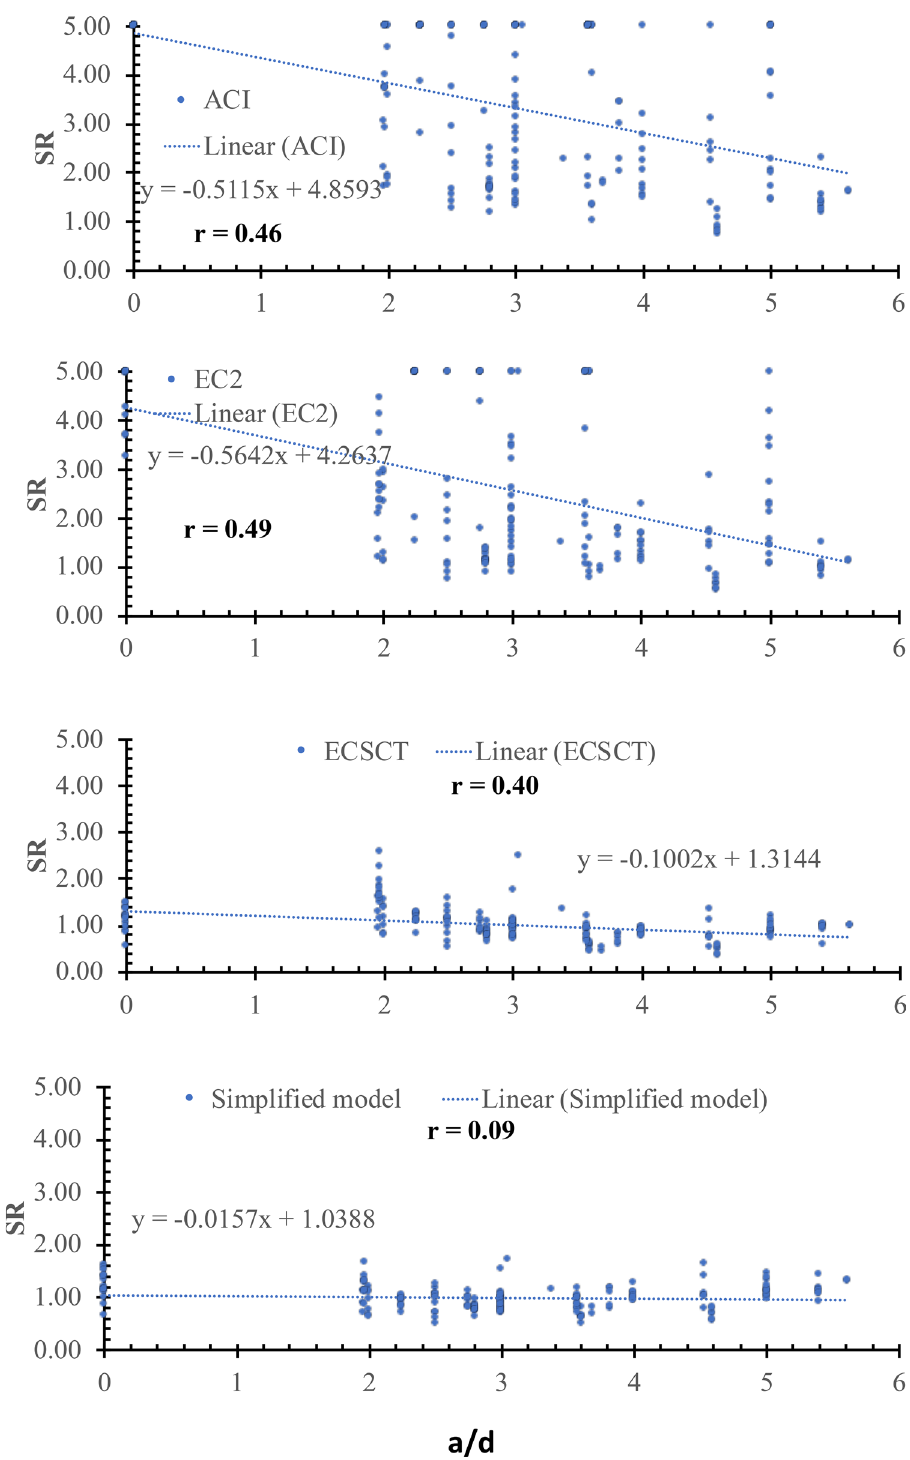
Figure 11. SR using various methods versus the d